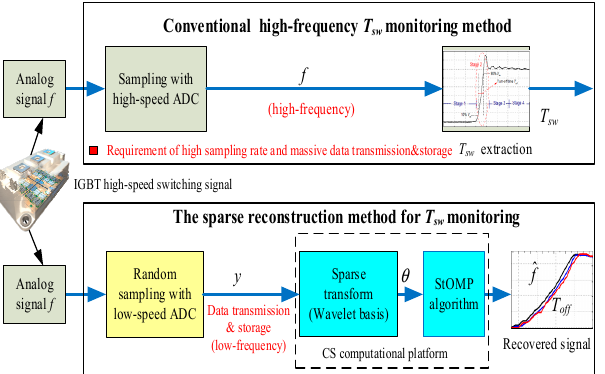
Figure 3. The propose sparse reconstruction method of IGBT switching signal for CM .